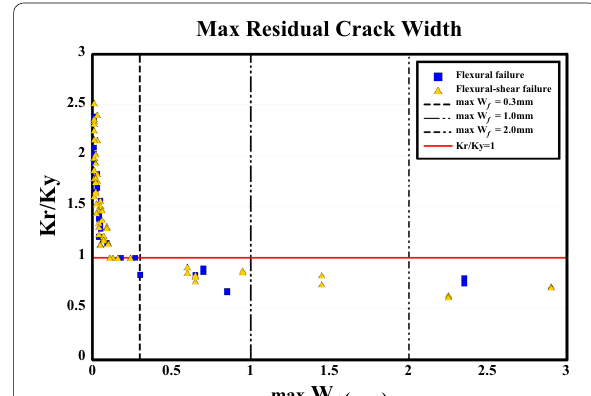
Fig. 16 Relationship between the maximum residual flexural crack width and residual stiffness for the specimens with the flexural and flexural–shear failure modes.